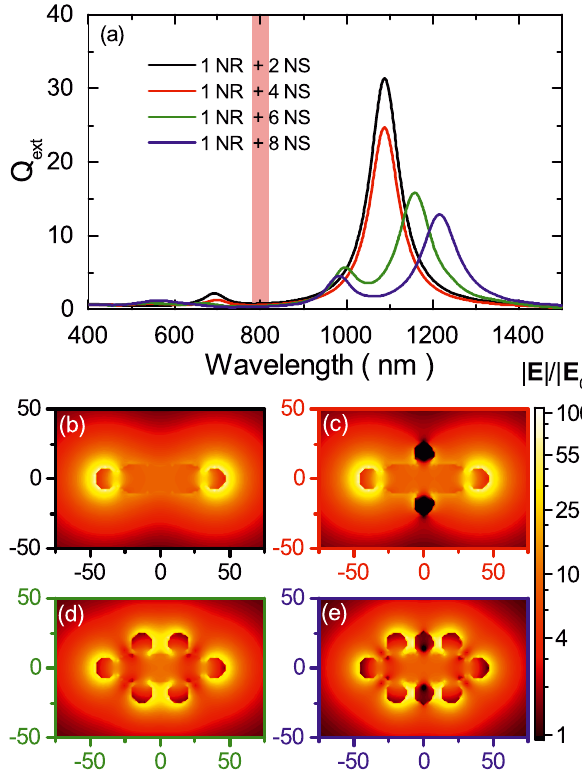
Figure 5: (a) Simulated extinction efficiency ( Q ext ) calculated for different structures, composed of a nanorod surrounded by a varying number of satellite spheres, as indicated in the legend.